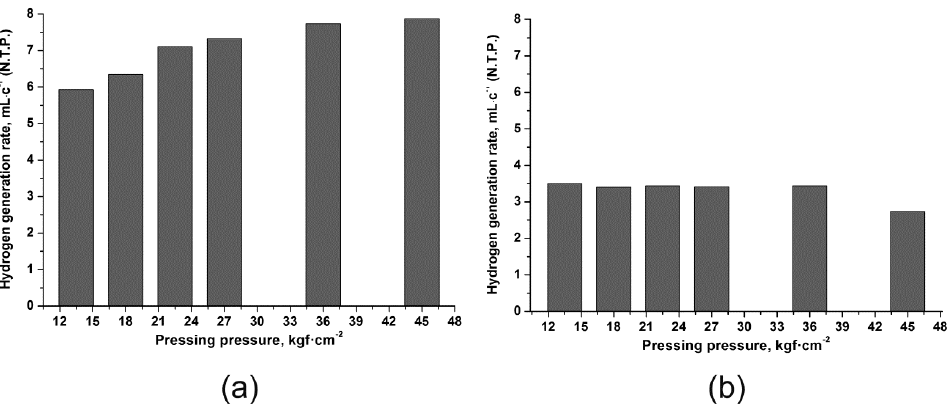
Figure 2. Effect of the pressing pressure on the hydrogen generation rate from NaBH 4 /Co composite with ( a ) cobalt chloride hexahydrate (NaBH 4 :Co = 60:1) and ( b ) Co x B-Cl catalyst prepared by the reduction of cobalt chloride in an aqueous sodium borohydride solution (NaBH 4 :Co = 30:1). Water volume: 5 mL. Temperature: 40 ° С .